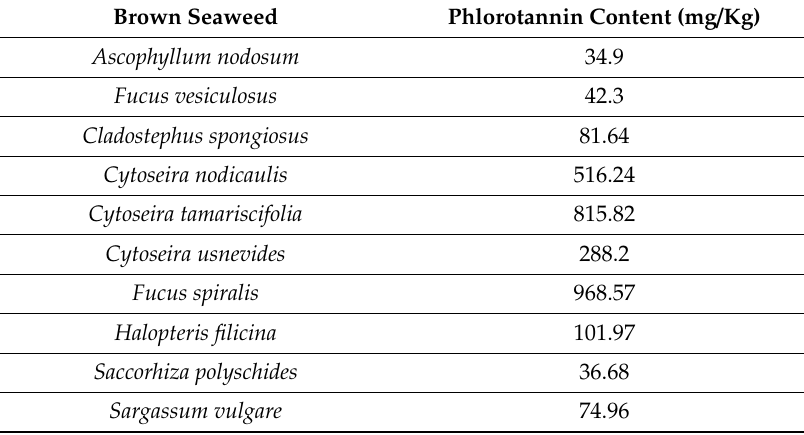
Table4. Quantityofphlorotanninsfoundindi ff erentbrownmacroalgae(adaptedfromLopes et al. [110] and Pavia and Toth